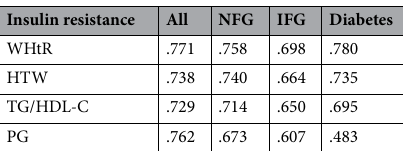
Table 5. ROC area under the curve. NFG normal fasting glucose, IFG impaired fasting glucose.